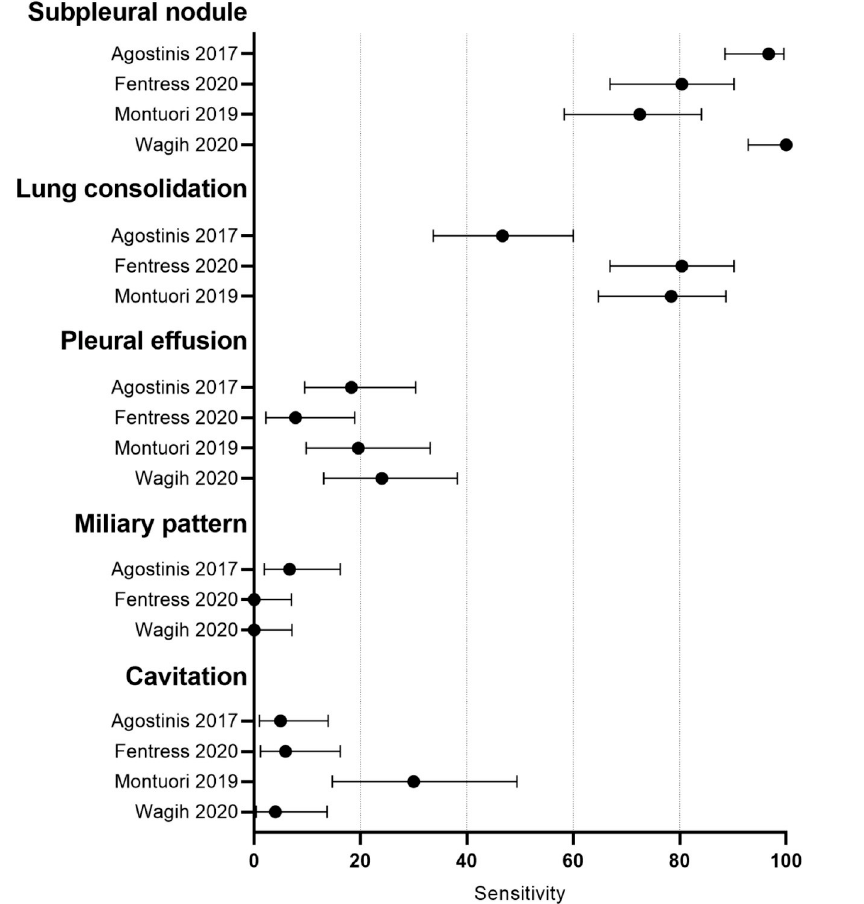
Fig 2. Forest plot showing sensitivity of different lung ultrasound findings in